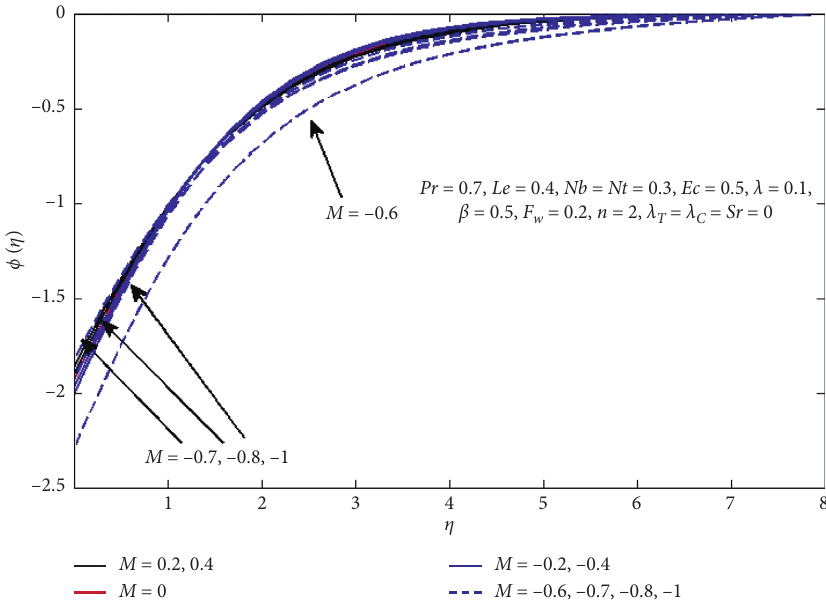
Figure 16: Variation of concentration ϕ concerning η with various values of M